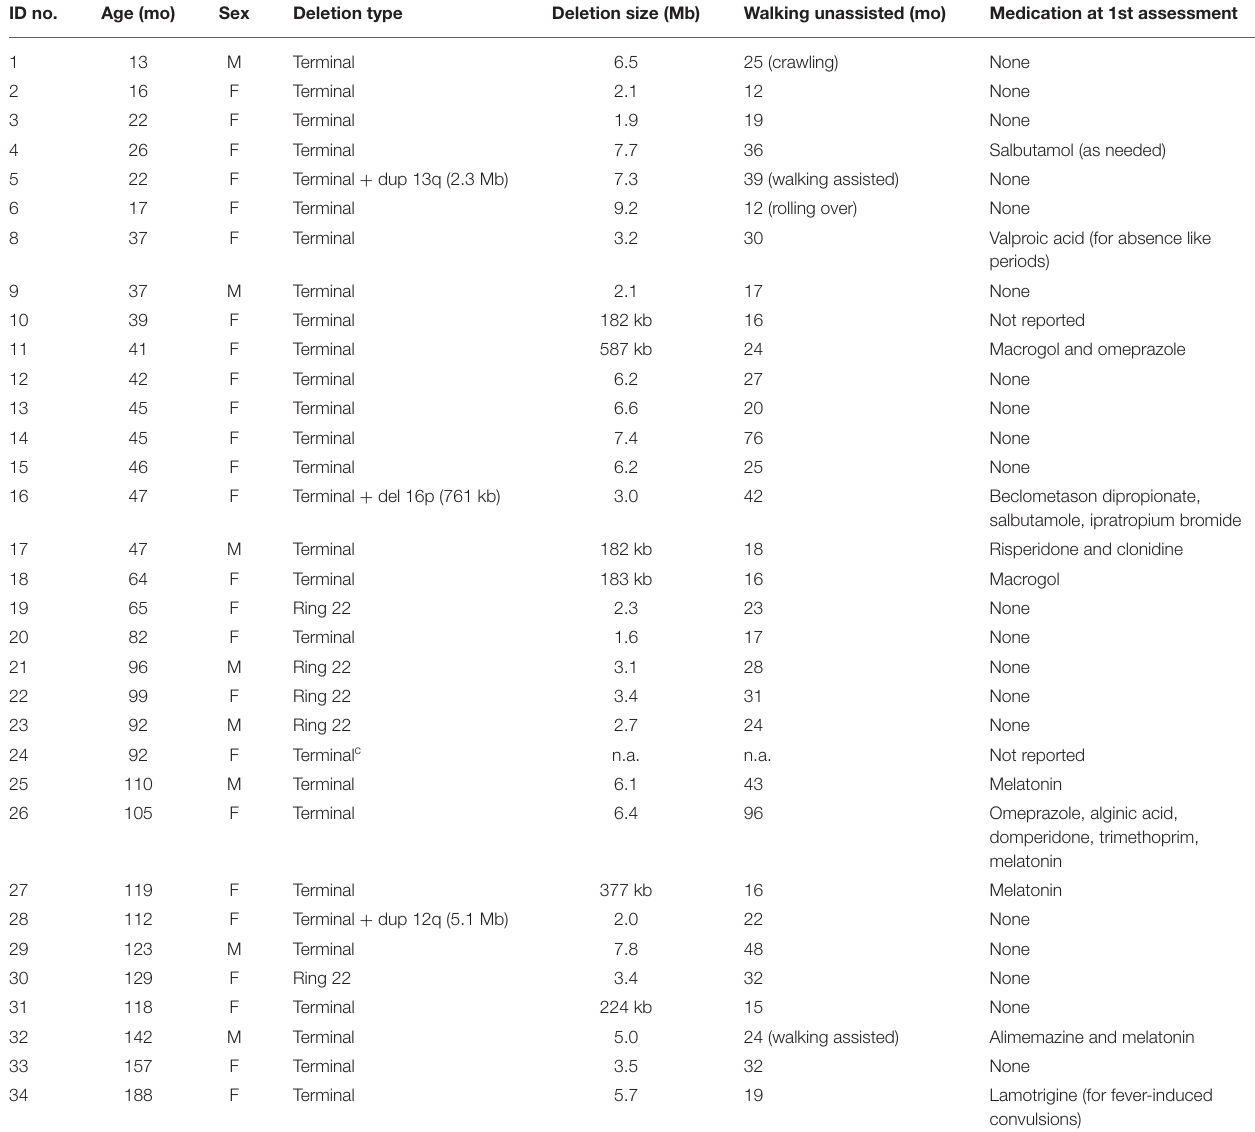
TABLE 1 | Characteristics of the children in the sample. ID